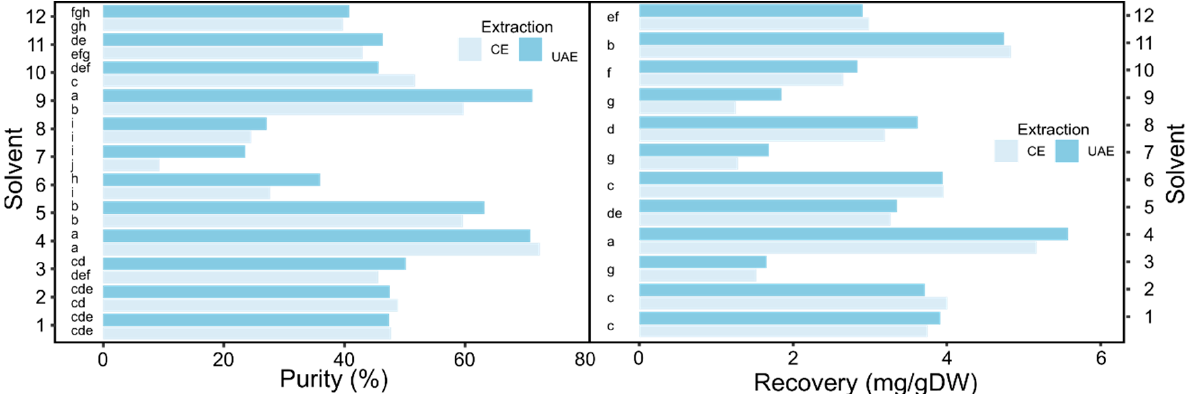
Figure 1. Mean of JB purity (right) and recovery (left) from L. austriacum HRc using UAE and CE. The samples with different letters are significantly different at p ≤ 0.05 according to Duncan test. Coefficient of variation (CV) purity = 4.9%; recovery = 7.3%. n = 3.